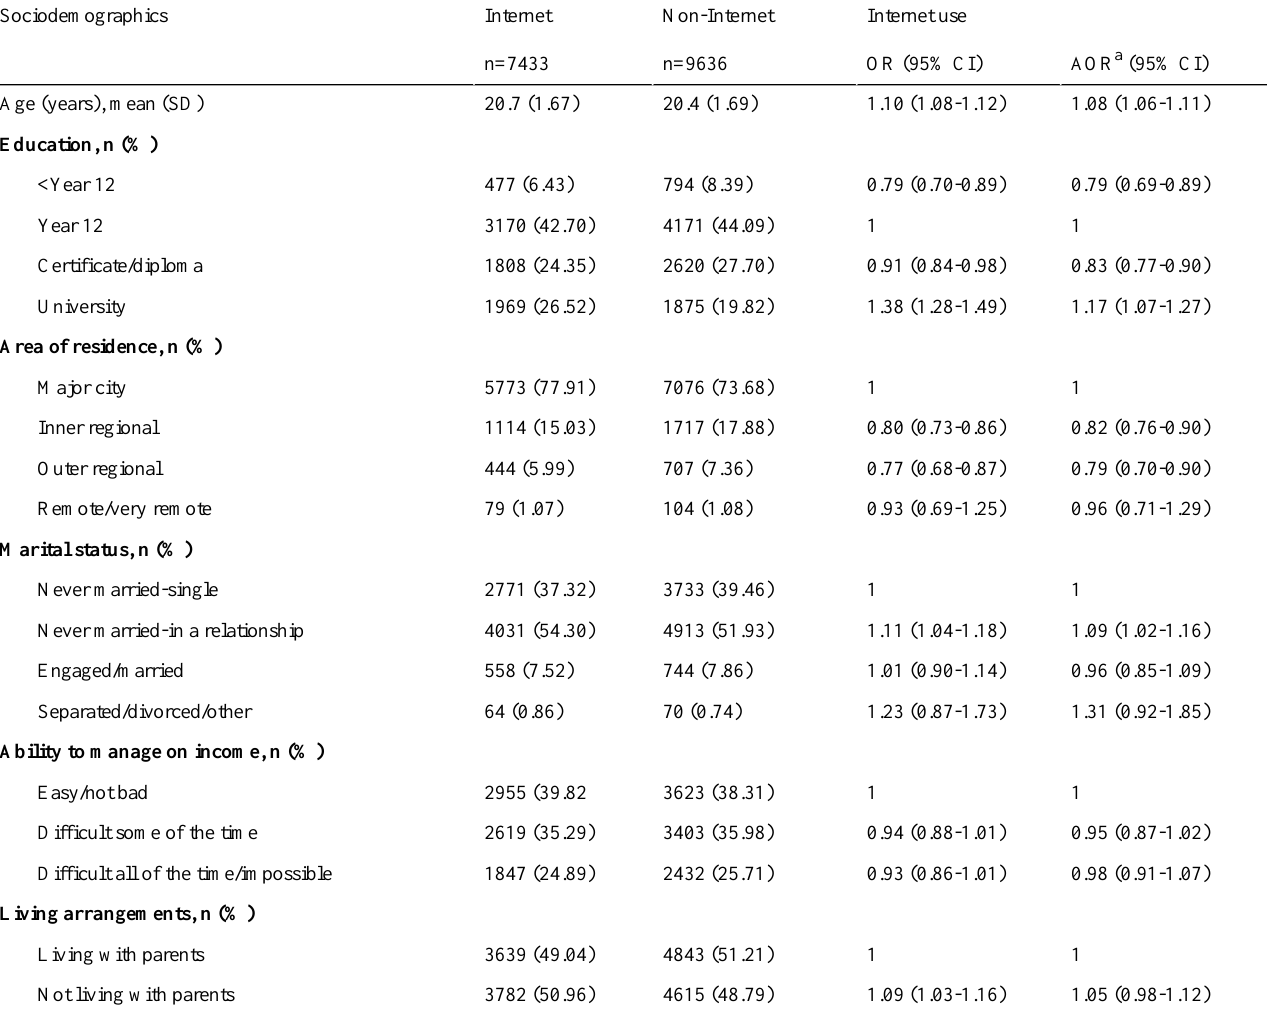
Table 1. Sociodemographic characteristics of women who do and do not use the Internet as a health information resource (N=17,069).